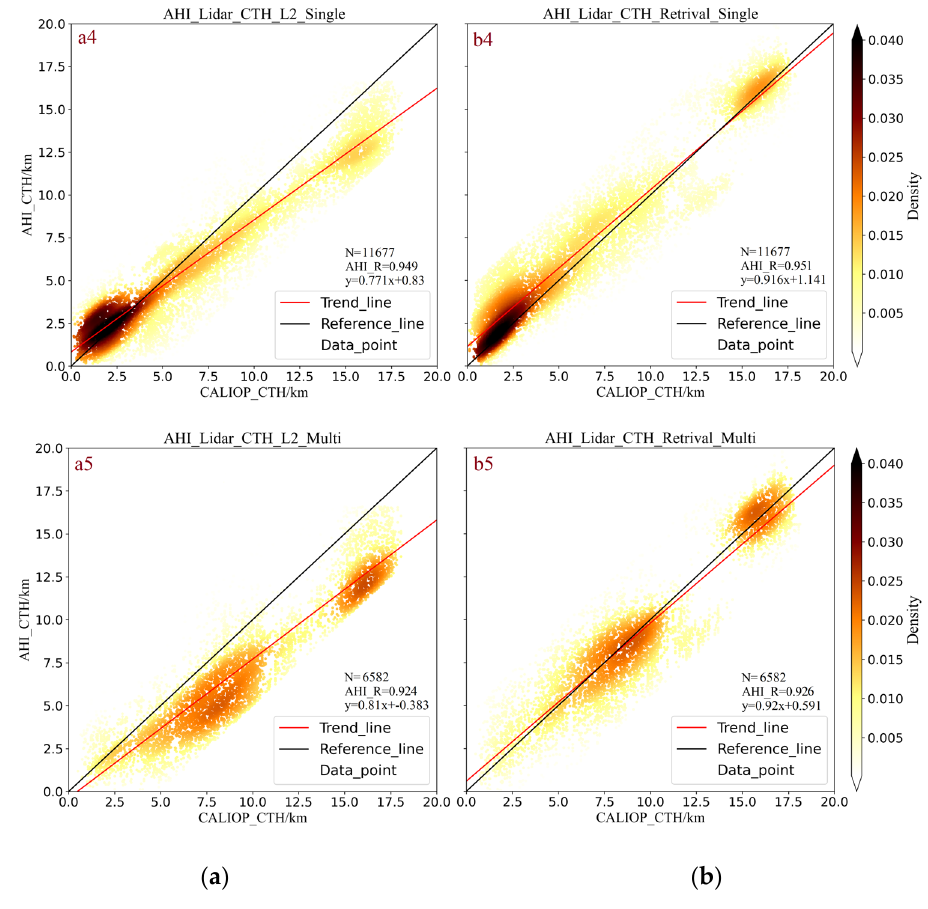
Figure 9. Scatter plots of CTH results compared with CALIOP in different cloud scenarios: ( a ) Himawari-8 L2 CTH; ( b ) XGBoost CTH; 1 ice cloud, 2 water cloud, 3 mixed cloud, 4 single-layer cloud, 5 multi-layer cloud.